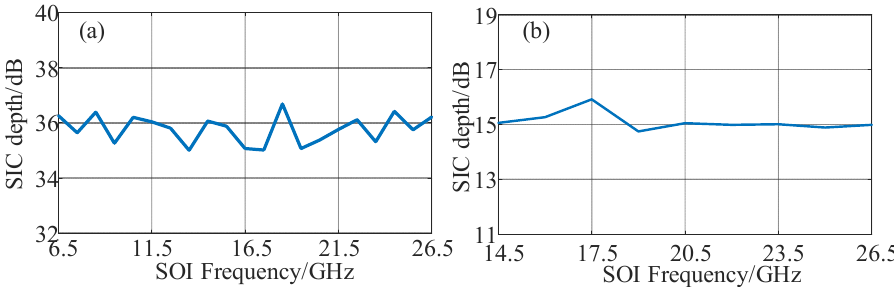
Figure 2. Electrical spectra of the down-converted IF signals with (yellow line) and without SIC (orange line) when the SOI signal was centered at ( i ) 12.5 GHz for fundamental down-conversion and ( ii ) 20.5 GHz for harmonic down-conversion with the SI bandwidth set as ( a ) 500 MHz, ( b ) 1 GHz, and ( c ) 2 GHz.